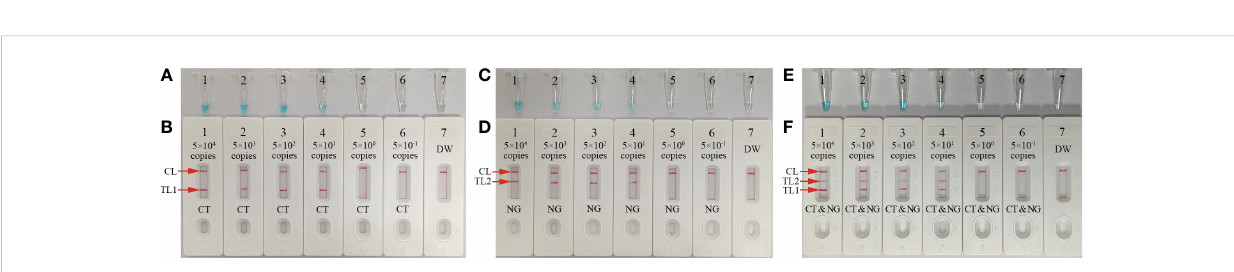
FIGURE 5 Sensitivity analysis of the mLAMP-AuNPs-LFB assay with serial nucleic acid template dilutions Serial dilutions (5.0×10 4 , 5.0×10 3 , 5.0×10 2 , 5.0×10 1 , 5.0×10 0 , and 5.0×10 -1 copies) of C. trachomatis ompA and N. gonorrhoeae orf1 plasmids were used as templates, and DW was used as the negative control. Results were simultaneously analyzed by visual reagent malachite green and the AuNPs-LFB. (A, B) : A sensitivity analysis of the C. trachomatis LAMP assay indicated its LoD was 50 copies per reaction. (C, D) : A sensitivity analysis of the N. gonorrhoeae LAMP assay indicated its LoD was 50 copies per reaction. (E, F) : A sensitivity analysis of the mLAMP assay for ompA and orf1 indicated its LoD was 50 copies of the nucleic acid template per reaction. Key: CL, control line; TL1, test line one; TL2, test line two; CT, C. trachomatis ; NG, N. gonorrhoeae ; MG, malachite green.